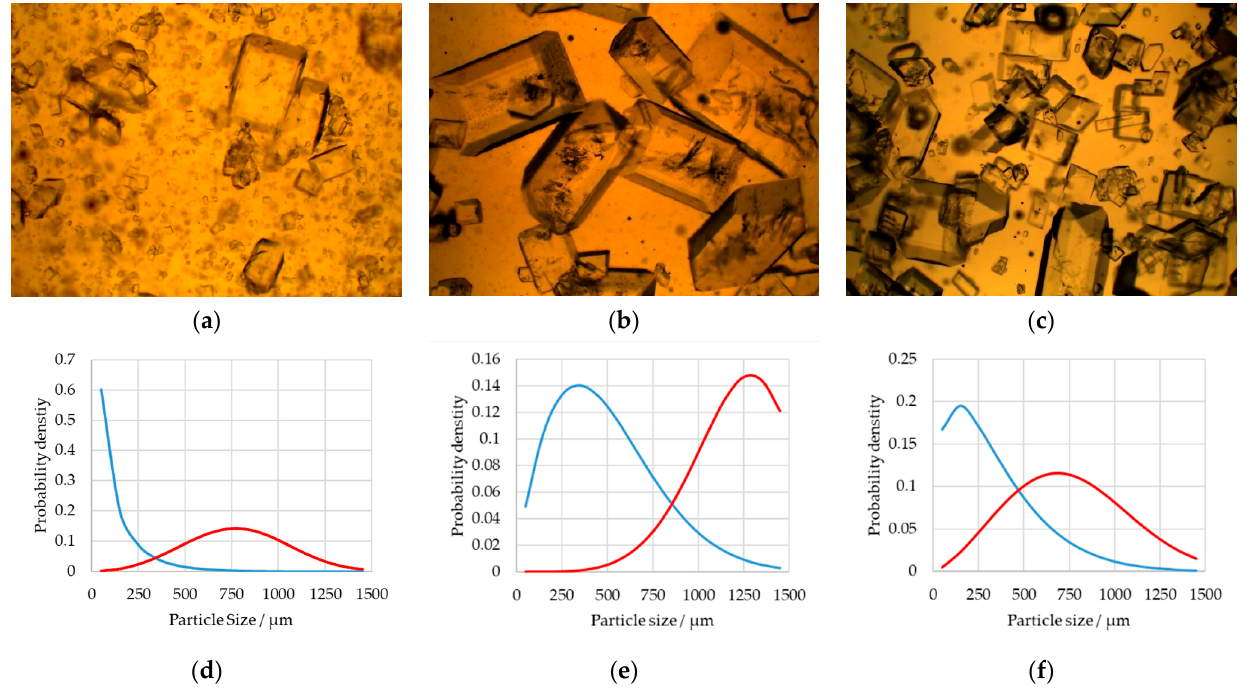
Figure 3. Crystallization results of three experiments in the DoE ( a – c ). In ( d – f ), the corresponding particle size densities are given. Here, the blue line is the q0 distribution, and the red is the q3 dis ‐ tribution.